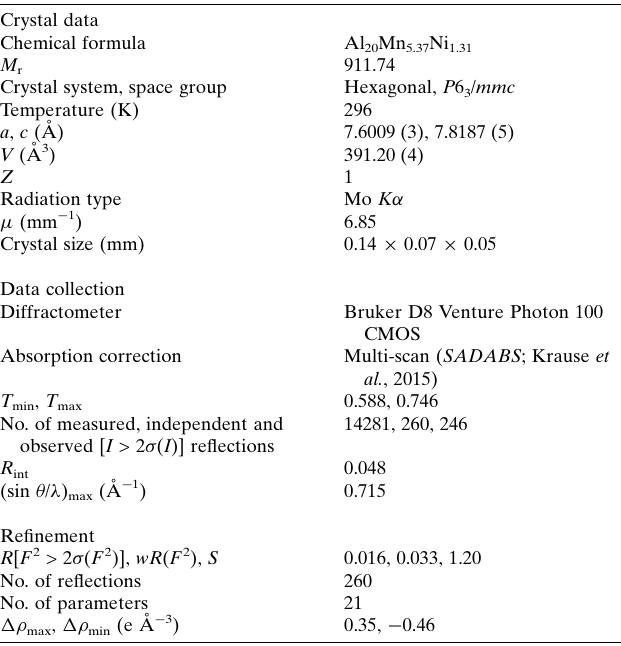
Table 1 Experimental details. Crystal data Chemical